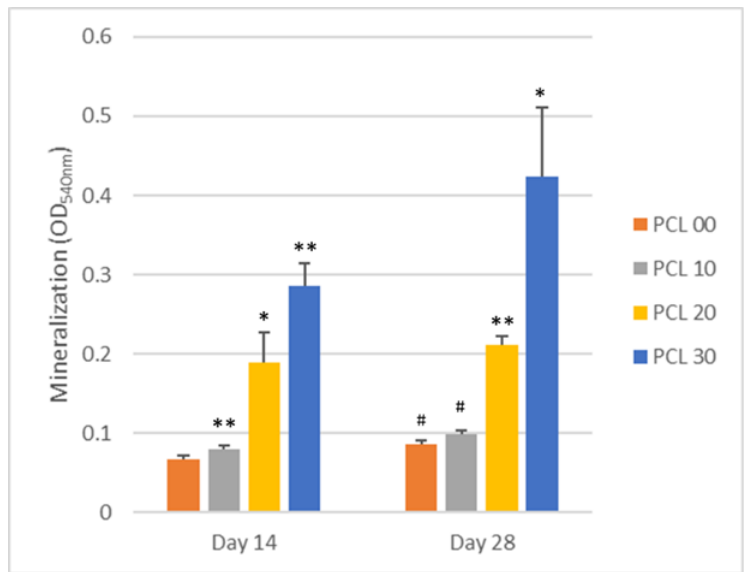
Figure 9. Mineralization assay of MG-63 cells when cultured on PCL/ β -TCP scaffold for 14, 21, and 28 days. Significant differences are indicated by *, p < 0.05, and **, p < 0.01, when compared to the control group on the same day. Significant differences are indicated by #, p < 0.05, when compared to the respective group on Day 14.